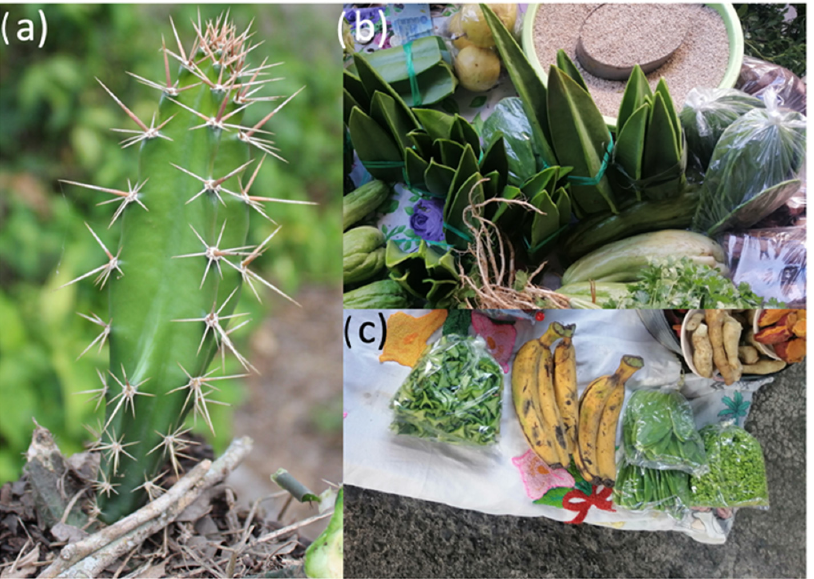
Figure 1. ( a ): Young stems of Acanthocereus tetragonus growing in the wild. ( b , c ): A. tetragonus and other vegetables produced by familiar farms and sold in local markets in northern Veracruz, M é